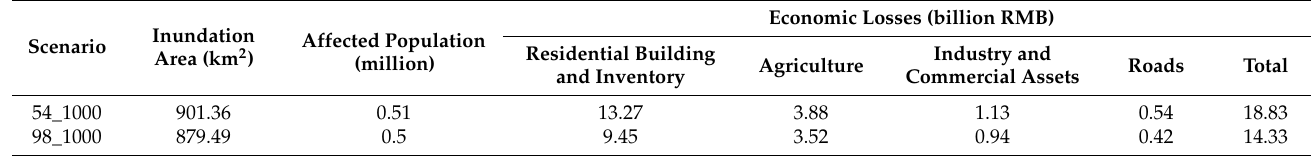
Table 6. The assessment results of social and economic